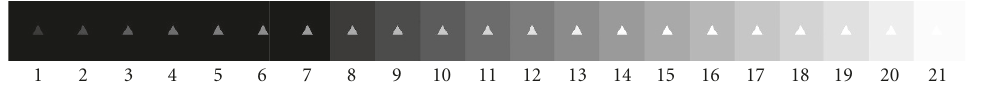
same size are used. The size of the equilateral triangle is